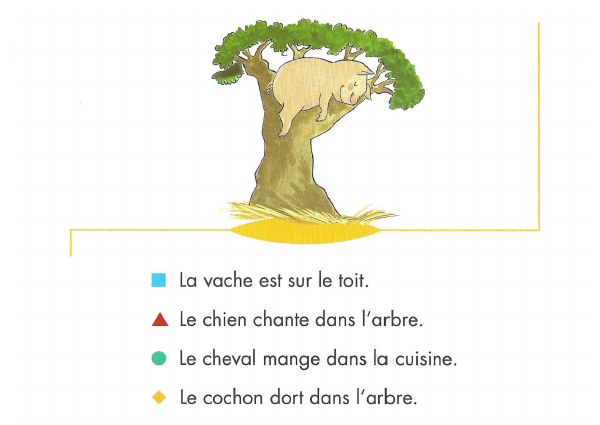
Figure 4. Example of a reading worksheet intended for personal work in autonomy in level of first year of primary school (edition PEMF&